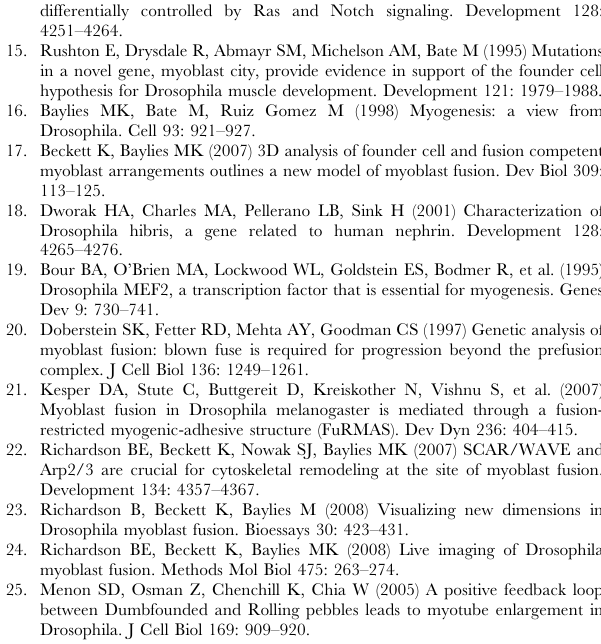
One population of S2 cells was co transfected with Flag tagged wild type and mutant Duf, detected with anti-Flag (green) and HA-Rols detected with anti-HA (magenta) (B,F,J,N,R) or Loner- V5 detected with anti-V5 (magenta) (D,H,L,P,T). Another population was transfected with Sns (red). Wild type Duf flag and Duf D CT1-flag translocate both Rols and Loner (A–H) to points of cell contact. Duf D CT2-flag and Duf 4phos-flag translocate Rols (I, J,Q,R) but not Loner (K,L,S,T). Duf D CT3-flag is unable to translocate Rols (M,N) and Loner (O,P). Dashed lines indicate cell outlines. Figure S3 Region between amino acids 687 and 830 is important for translocation of Rols in vivo . Stage 15 duf, rst embryos rescued with the indicated Duf constructs. FCM and muscles labeled with anti-Titin (red) and anti-Rols (green). Arrow indicates Rols at the site of FCM-precursor/myotube contact (arrow in B, D, F, H, L). Rols is not enriched at the point of FCM- muscle/precursor contact in embryos rescued with Duf D CT3-flag (J, arrowhead). Figure S4 Duf mutant forms that successfully rescue the duf, rst mutant. Stage 15 DA1 muscles labelled with anti-MHC (red) and anti-eve (green). UAS transgenic constructs Duf TM DE Cadh-flag (A), Duf TM Sema 1a-flag (B), Duf PADVI-flag (C) and Duf PDZ-flag (D) driven by 24B Gal4 are able to rescue the duf, rst mutant. Figure S5 Rescue of the duf, rst mutant using a founder specific driver and the localization of Rols in vivo . (A) Average nuclear number per DA1 muscle in embryos rescued with UAS-Duf flag and UAS Duf mutant constructs expressed under Dmef2-Gal4, in comparison with wild type (WT) and the duf, rst mutant. (B–K) Stage 15 embryos labeled with anti-DTitin (red) and anti-Rols (green). Arrow indicates Rols at the site of FCM-precursor/ myotube contact. Rols does not localize to the site of fusion in duf, rst embryos rescued with Duf D CT3-flag (H,I, arrowhead). In B–G the FCM are below the plane of focus.